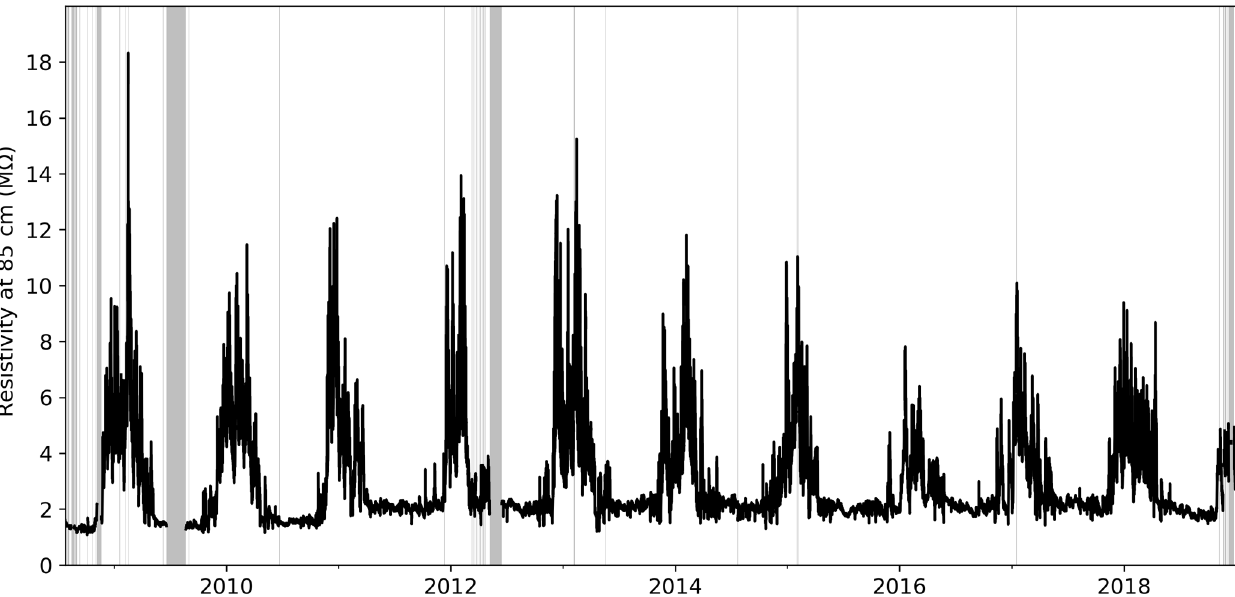
Figure 9. Resistivity time series measured at 85cm depth in an intact rock wall at position MH10. Gray bars indicate data